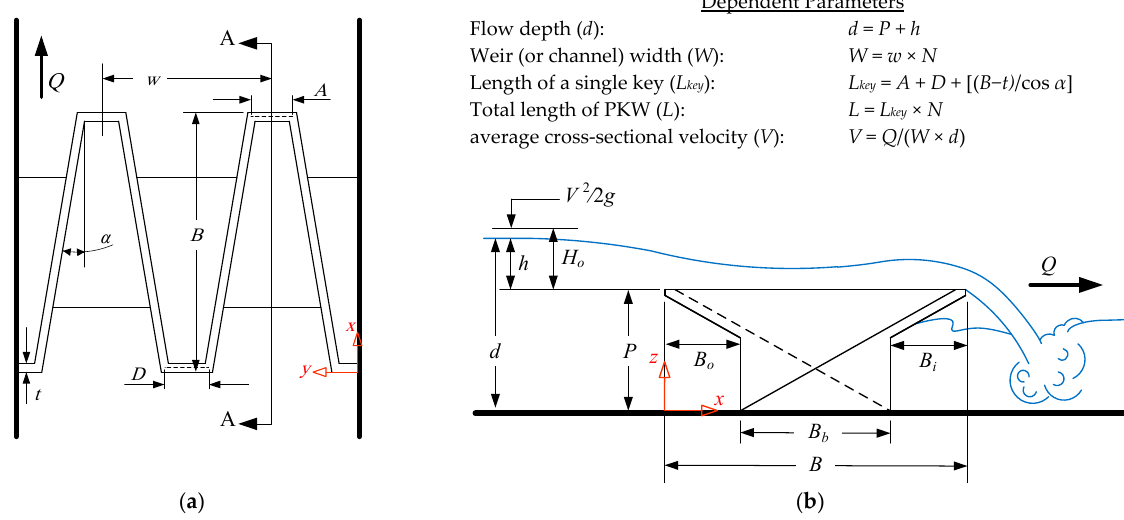
Figure 1. PKW schematic: (a) plan view; (b) section view A-A.